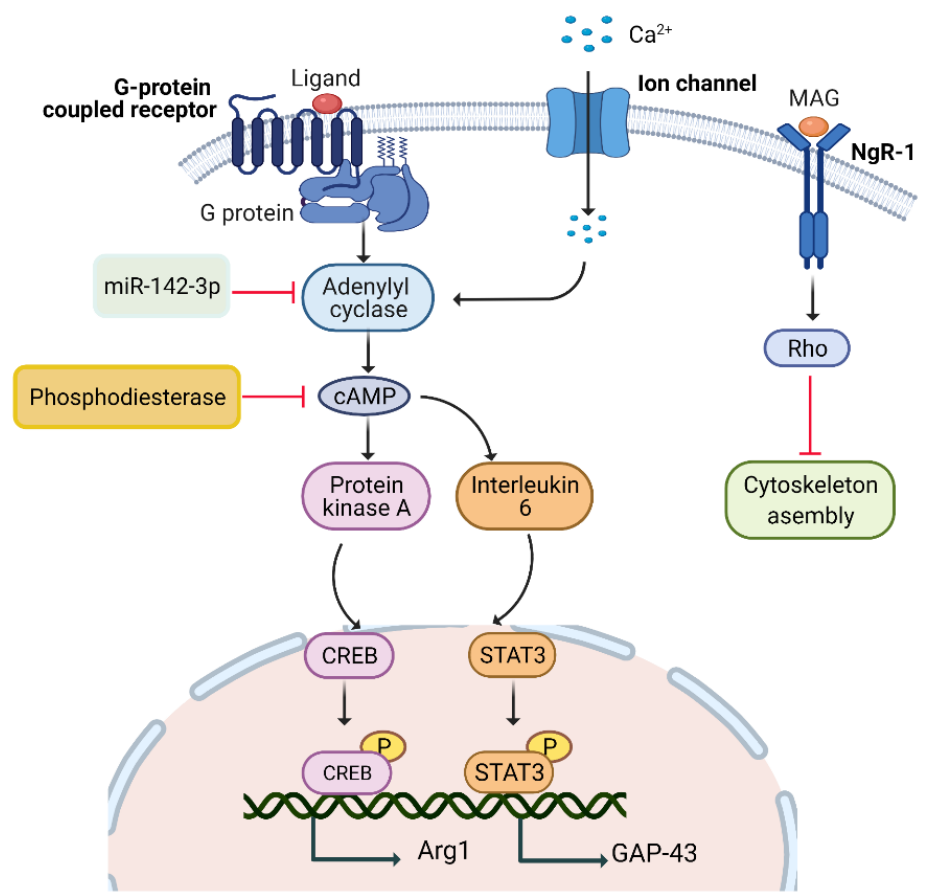
Figure 1. cAMP pathway. Peripheral nerve injury triggers calcium release that upregulates cAMP level via enhancing AC9 expression and regulates three pathways in DRG neurons to promote neurite outgrowth. miR-142-3p, PKA, Rho and phosphodiesterase are the target sites of AC9, Rho, cytoskeletal assembly, and cAMP, respectively, and can be used as therapeutic targets to enhance neurite outgrowth. cAMP: cycline adenosine monophosphate; AC9: adenylyl cyclase 9; DRG: dorsal root ganglion; PKA: protein kinase A; MAG: myelin-associated glycoproteins; NgR1: NOGO receptor; CREB: cAMP response element-binding protein; STAT3: signal transducer and activator of transcription 3; Gap-43 : growth-associated proteins; Arg-1 : arginase-1.